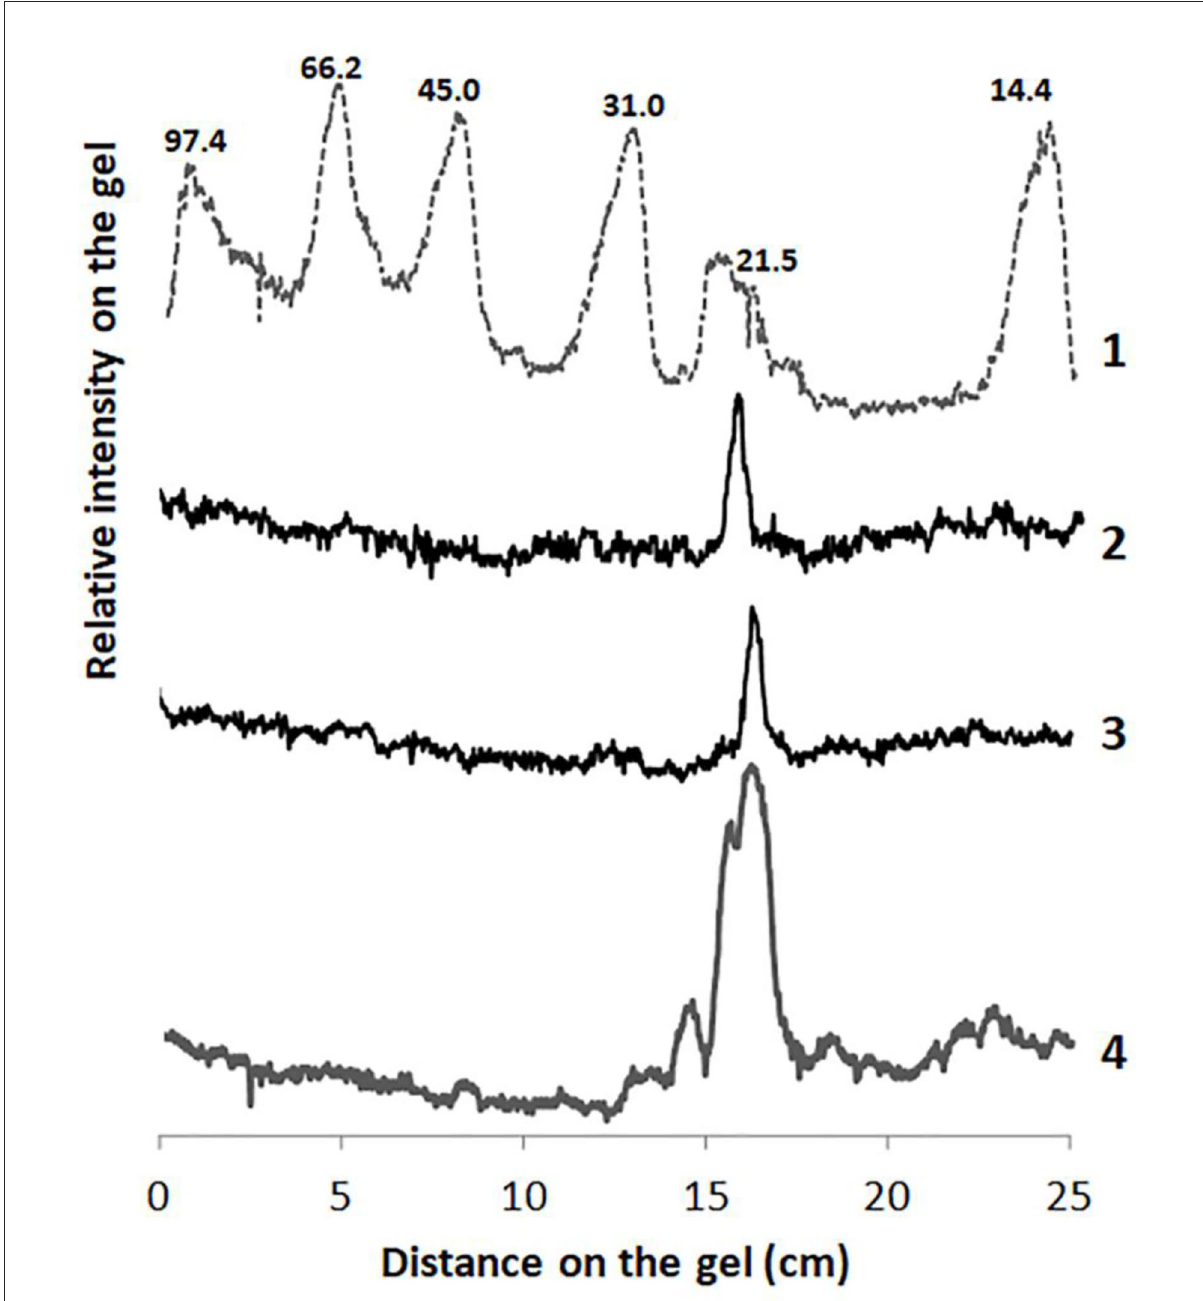
FIGURE1 Densitography of SDS-PAGE of Ascelpias curassavica proteases. An intensity arbitrary unit (IAU) is plotted as a function of the distance on the gel (cm). Lane 1: Molecular-weight markers (low range kit, BioRad). Lane 2: Asclepain cII. Lane 3: Asclepain cI. Lane 4: Crude extract.